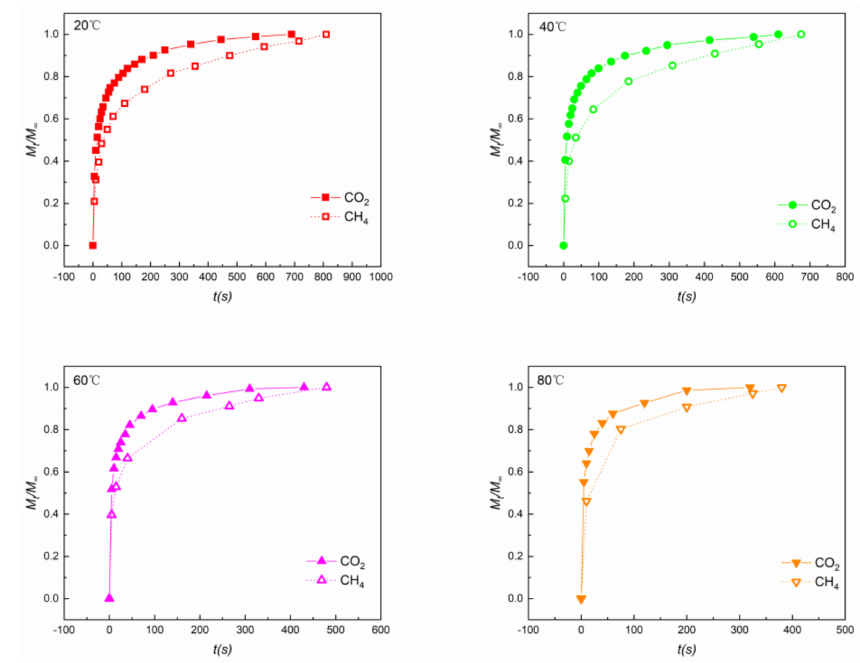
Figure 6. Comparison of adsorption rates between CO 2 and CH 4 at different